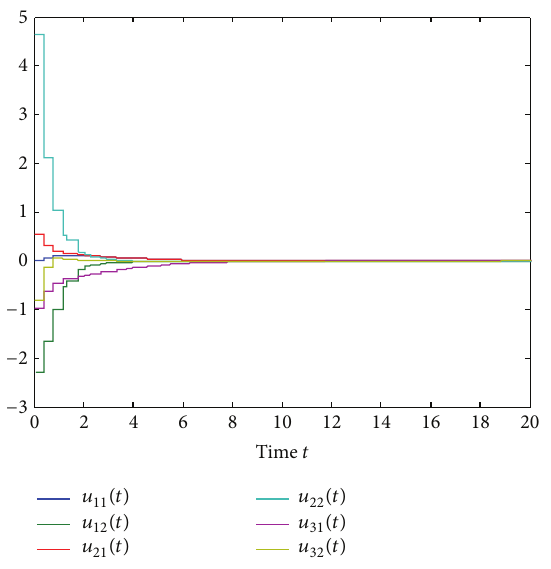
Figure 6: Sampled-data control inputs.